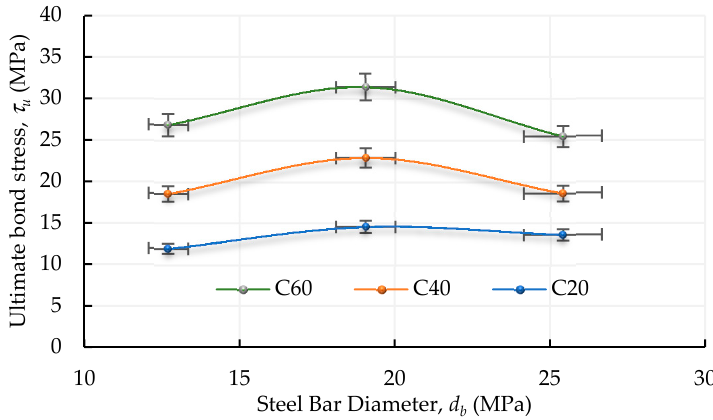
Figure 15. Relationship between the rebar diameter and ultimate bond stress for various concrete